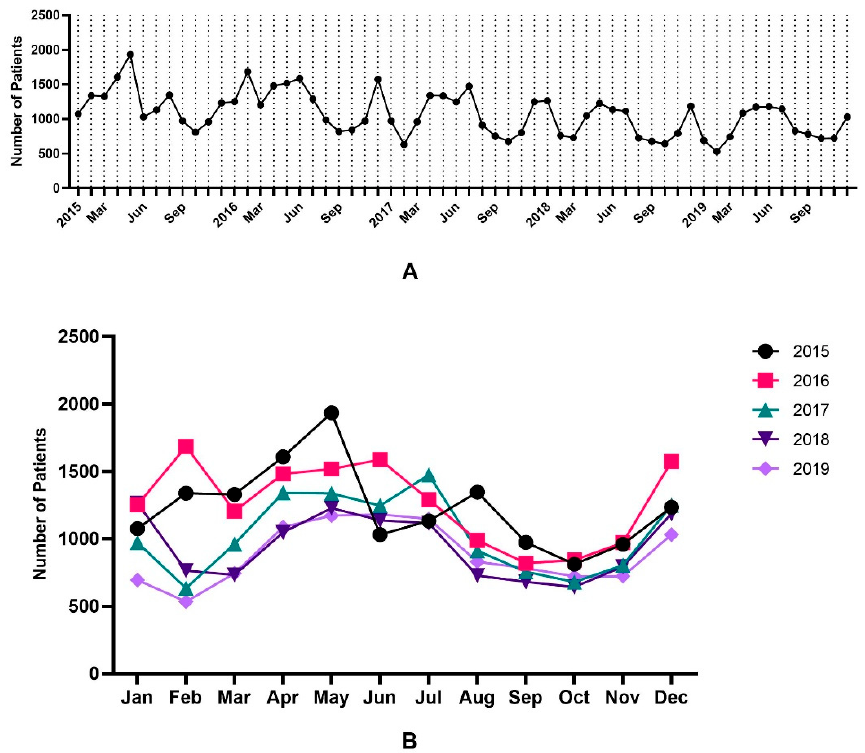
Figure 5. Annual incidence trend of febrile convulsion from 2015 to 2019; ( A ). Monthly trend analysis of febrile convulsion from 2015 to 2019; ( B ). Monthly trend analysis of febrile convulsion according to year.